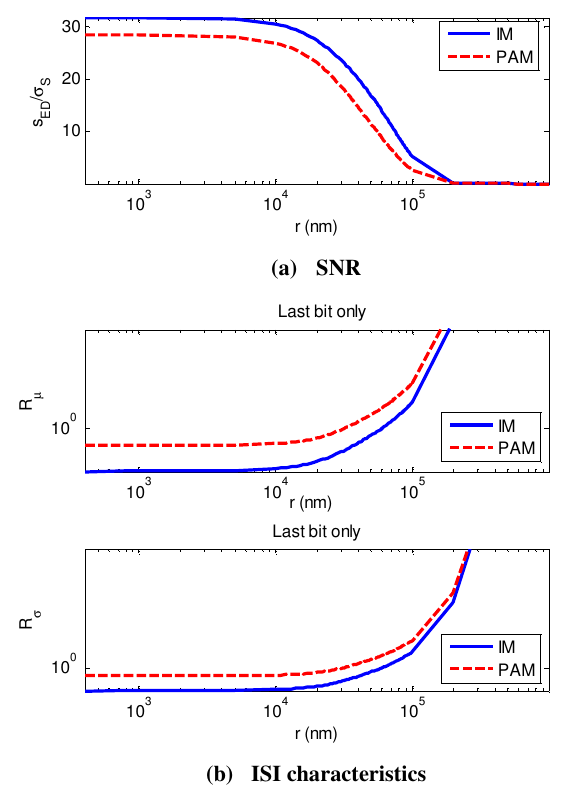
Fig. 3. Diffusion noise characteristics in the presence of